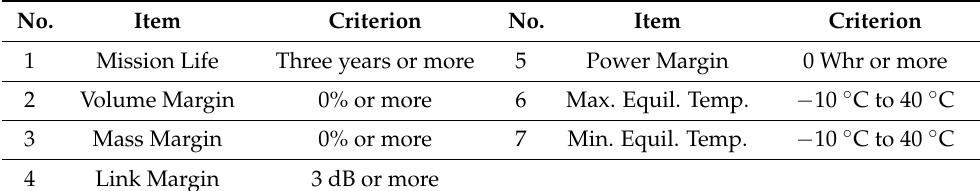
Table 7. Examples of basic feasibility